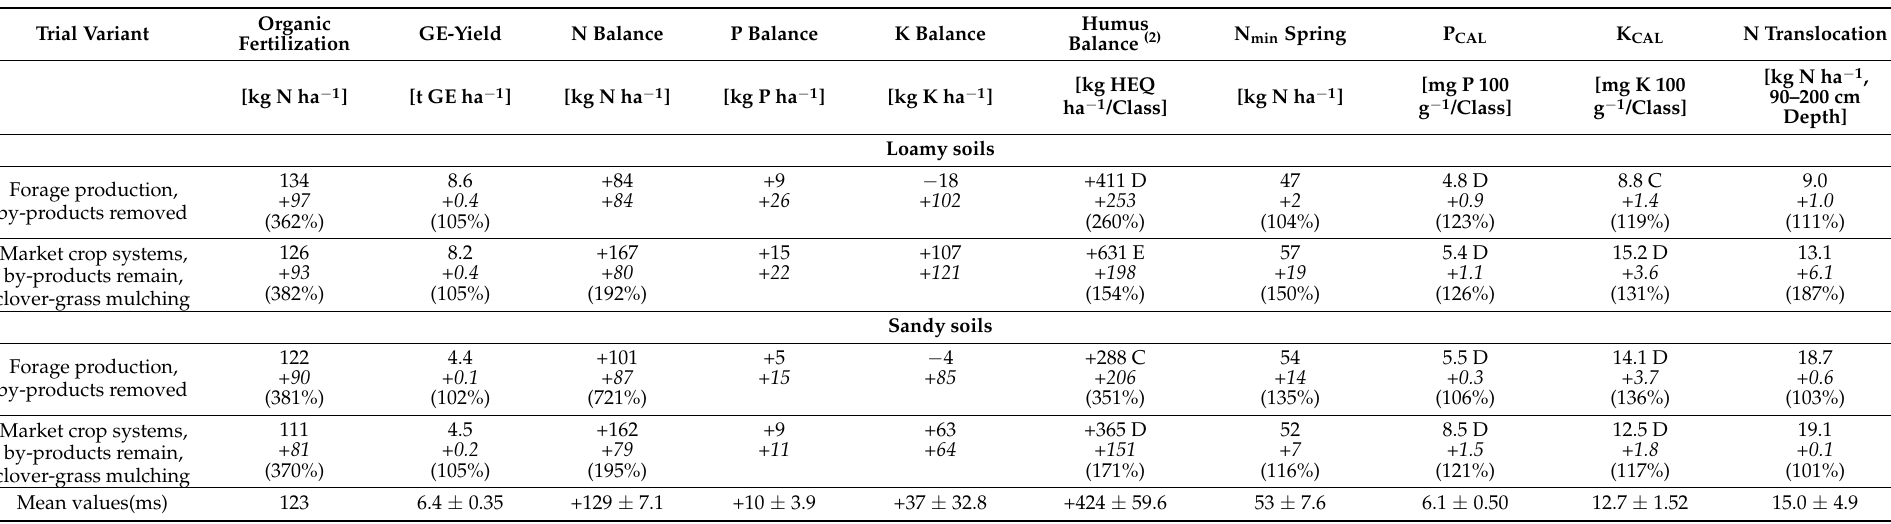
Table 9. Mean values as well as absolute (italic) and relative change (in brackets) compared to a mean intensity [=100%, see Table 2], and supply classes (1) of some characteristics of crop yields, nutrient balances, and soil fertility of forage and market crop systems at a fertilization level around 2.0 LU ha − 1 from long-term field trials on loamy and sandy